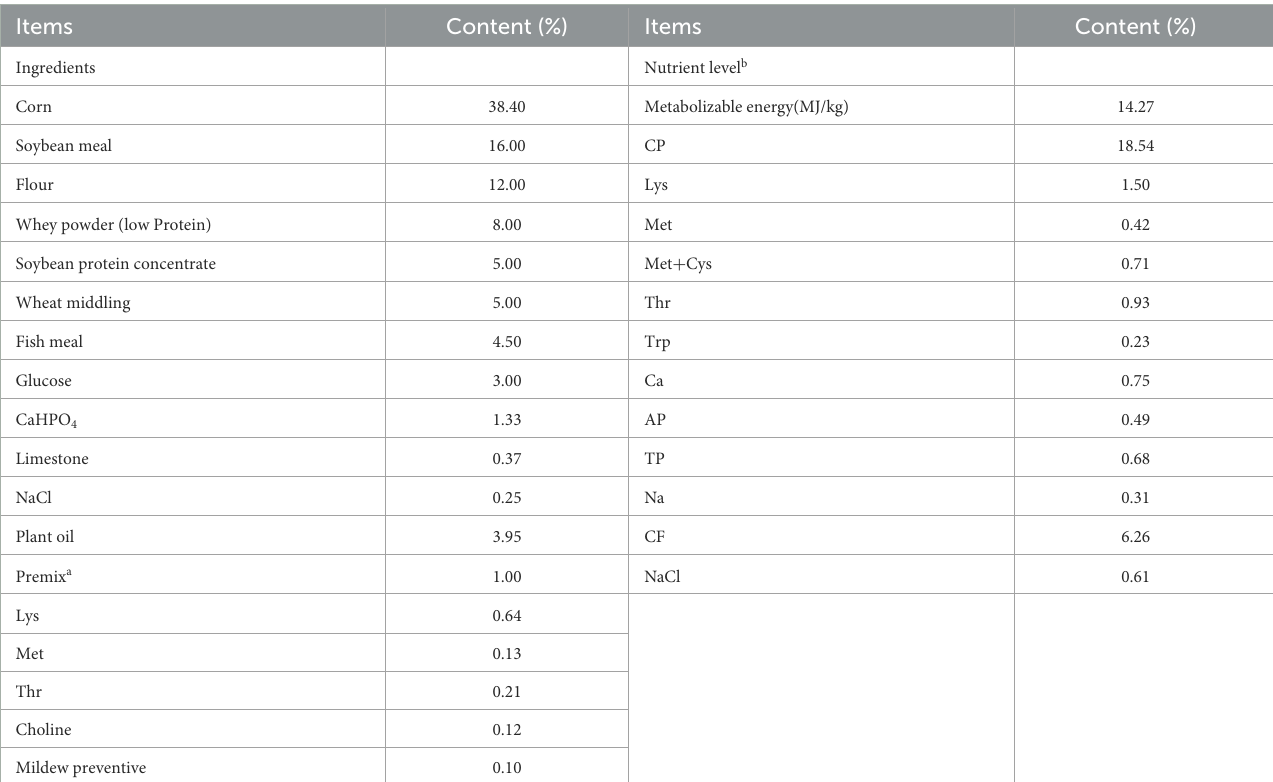
TABLE 1 Composition and nutrient levels of the basal